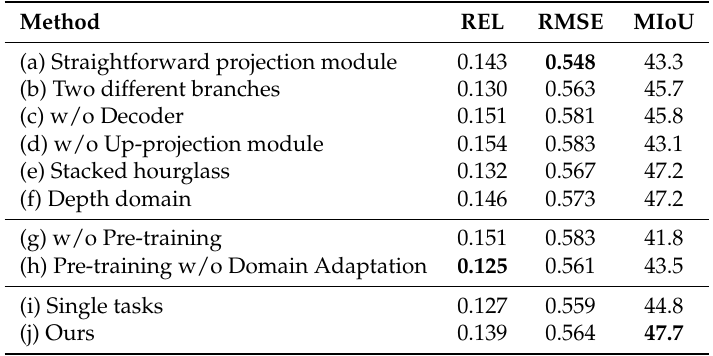
Table 4. Ablation experiments. The bold items represent the best